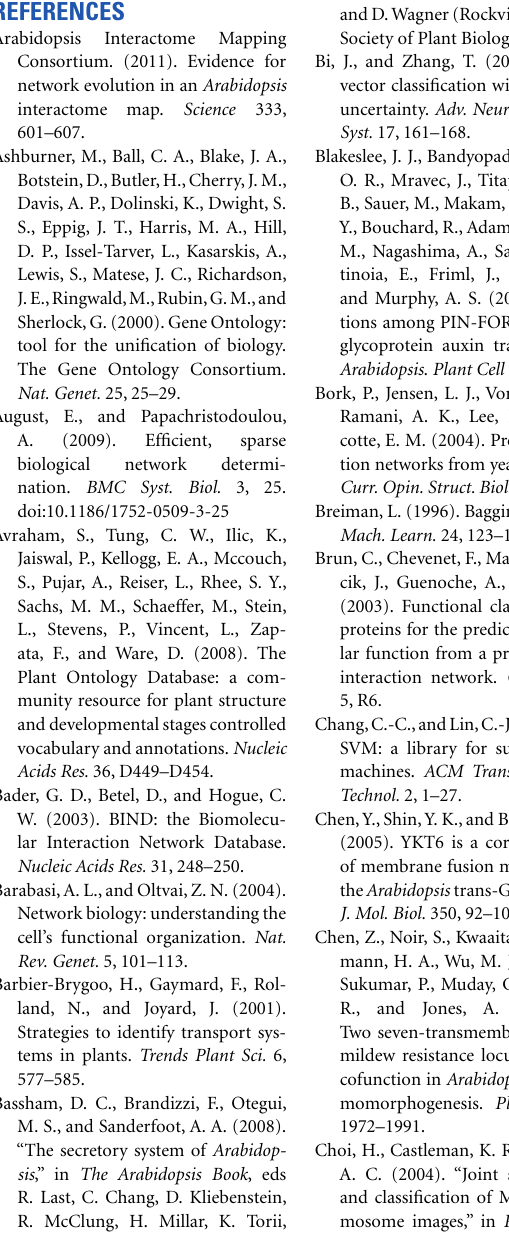
Table S17 | Family classification of the 145 proteins in the sub-network that was analyzed functionally. Table S18 | Family classification for each of the 227 interaction pairs. Table S19 | A list of significantly enriched family level interactions. Figure S1 | Comparison of number of potential positive interactions in REF-NET (blue) and PRIMARY-NET (red) at different FDR thresholds. Figure S2 | Distribution of coefficient of variation of the replicates for the second mbSUS assays using cell growth in the absence of histidine in different concentrations of methionine (MET0 = 0 μ M, MET150 = 150 μ M, MET500 = 500 μ M).